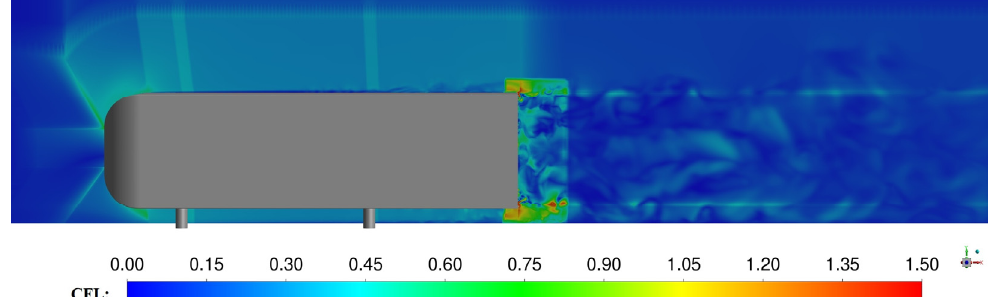
Figure 6. CFL distribution on the symmetry plane (z = 0).